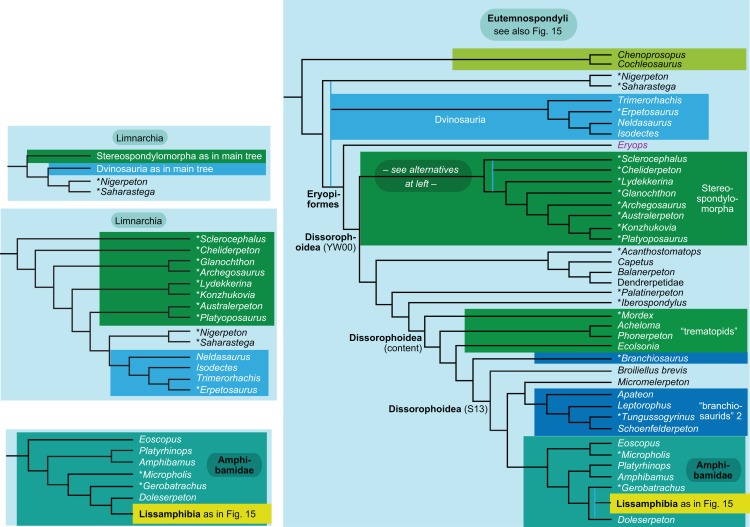
Eutemnospondyl phylogeny from those MPTs from Analysis R5 that are not represented in Fig. 15; see the legend of Fig. 15 for more information.